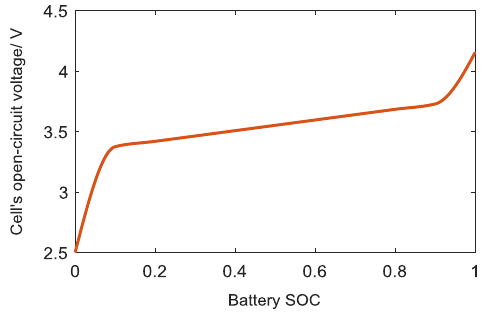
Figure 4. Open-circuit voltage (OCV)–SOC curve.